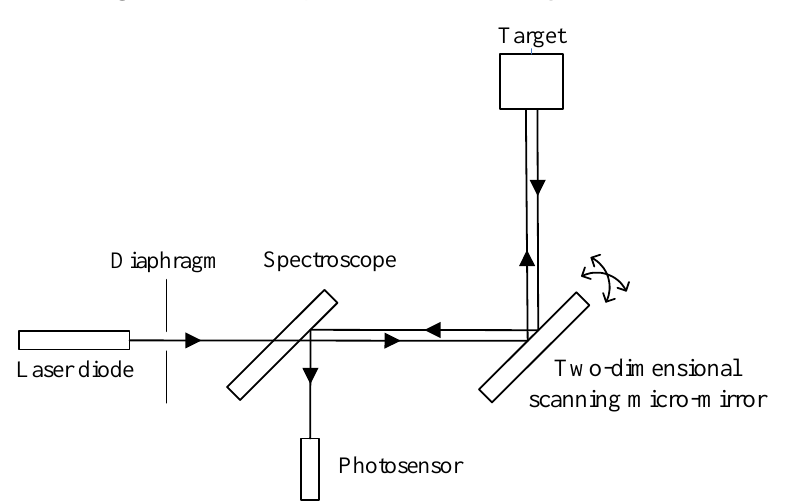
Figure 12. Beam path of MOEMS target